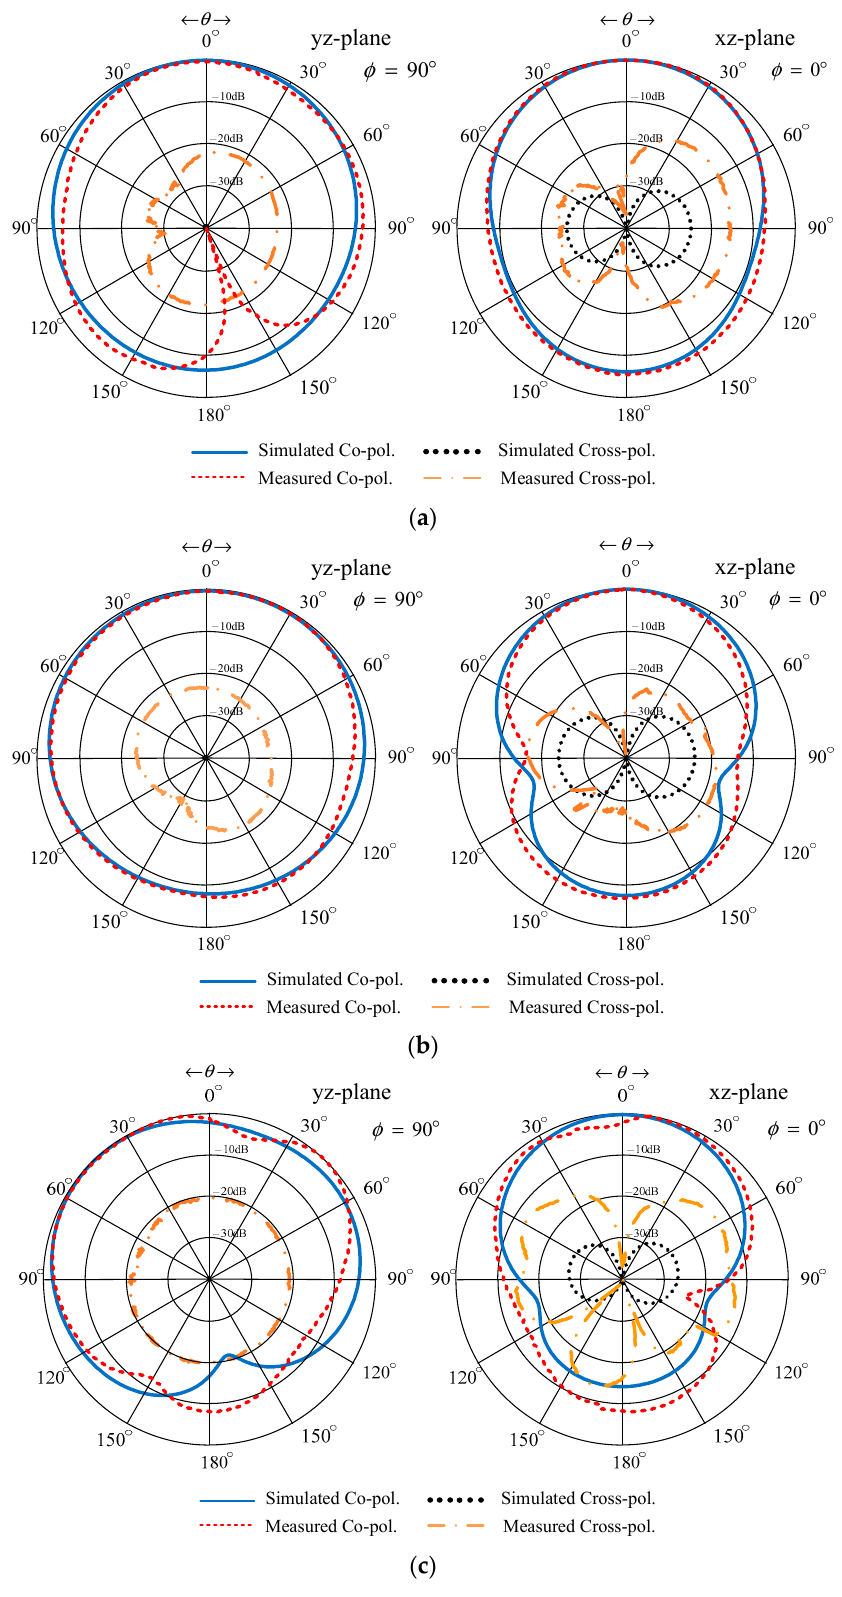
Figure 19. Simulated and measured xz- and yz-plane radiation patterns of the portable wideband directional antenna scheme: ( a ) 470 MHz, ( b ) 680 MHz, and ( c ) 890 MHz.